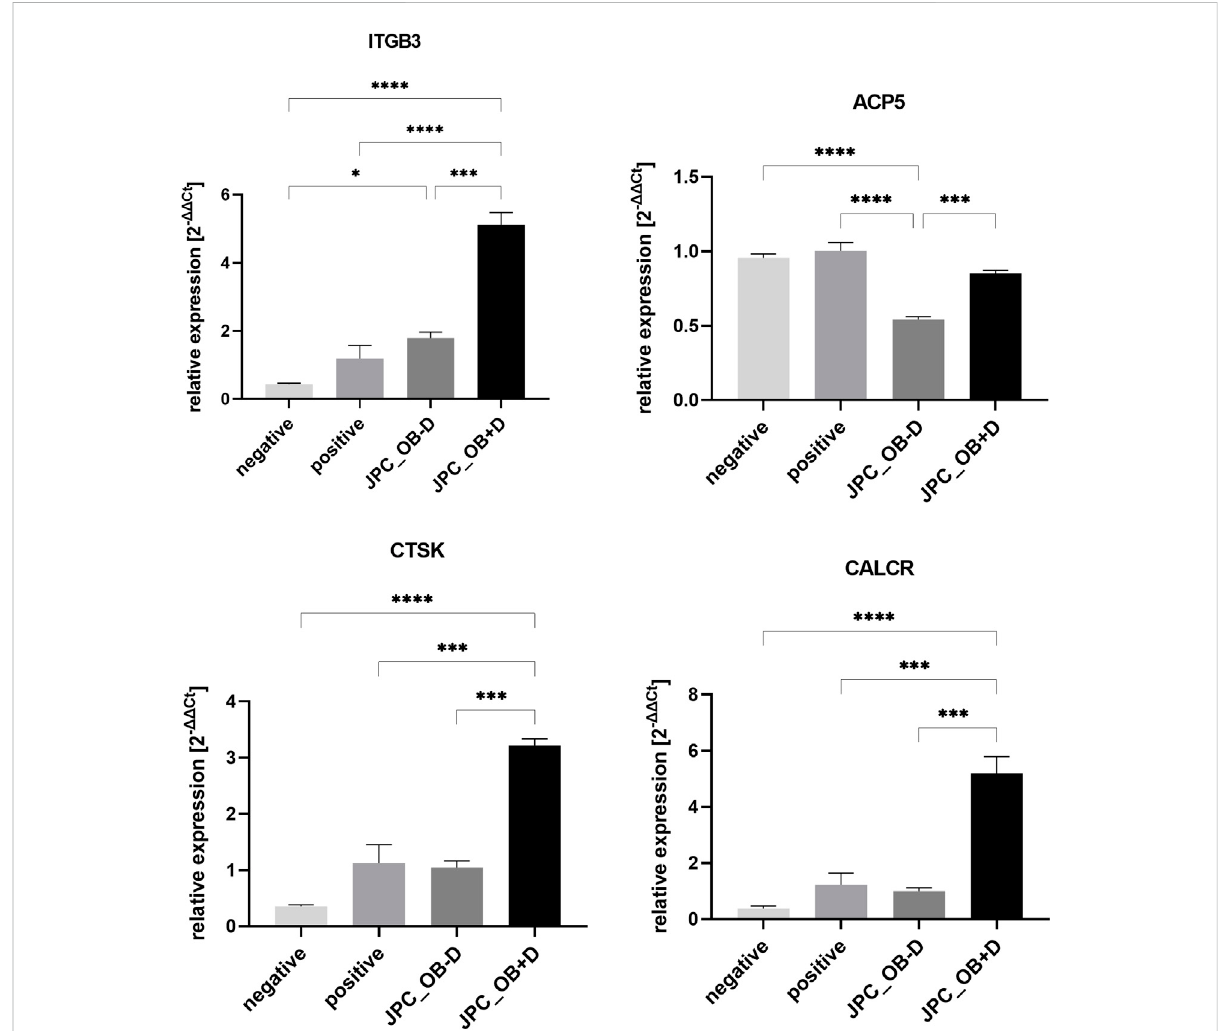
FIGURE 13 RelativeexpressionofosteoclastmarkergenesITGB3,ACP5(TRAP),CTSKandCALCR.M-CSF+RANKLstimulatedPBMCswereincubatedwith secretome(10x) ofJPCstreatedwithosteogenicmedium withdexa (JPC_OB+D) andwithout dexa(JPC_OB-D).ControlsweretreatedwithM-CSF (negative)andM-CSF+RANKL(positive).After6daysRNAwasisolatedandgeneexpressionwasanalyzedbyqPCR. Δ Ctvalueswerecalculatedusing the housekeeping gene GAPDH as endogenous reference. Gene expression induction (2 - ΔΔ Ct ) was calculated relative to the positive control. Thedifferenttreatmentswerecomparedusingone-wayANOVAandTuckeysmultiplecomparisontest( n =3,*= p < 0.05,***= p < 0.001,****= p <